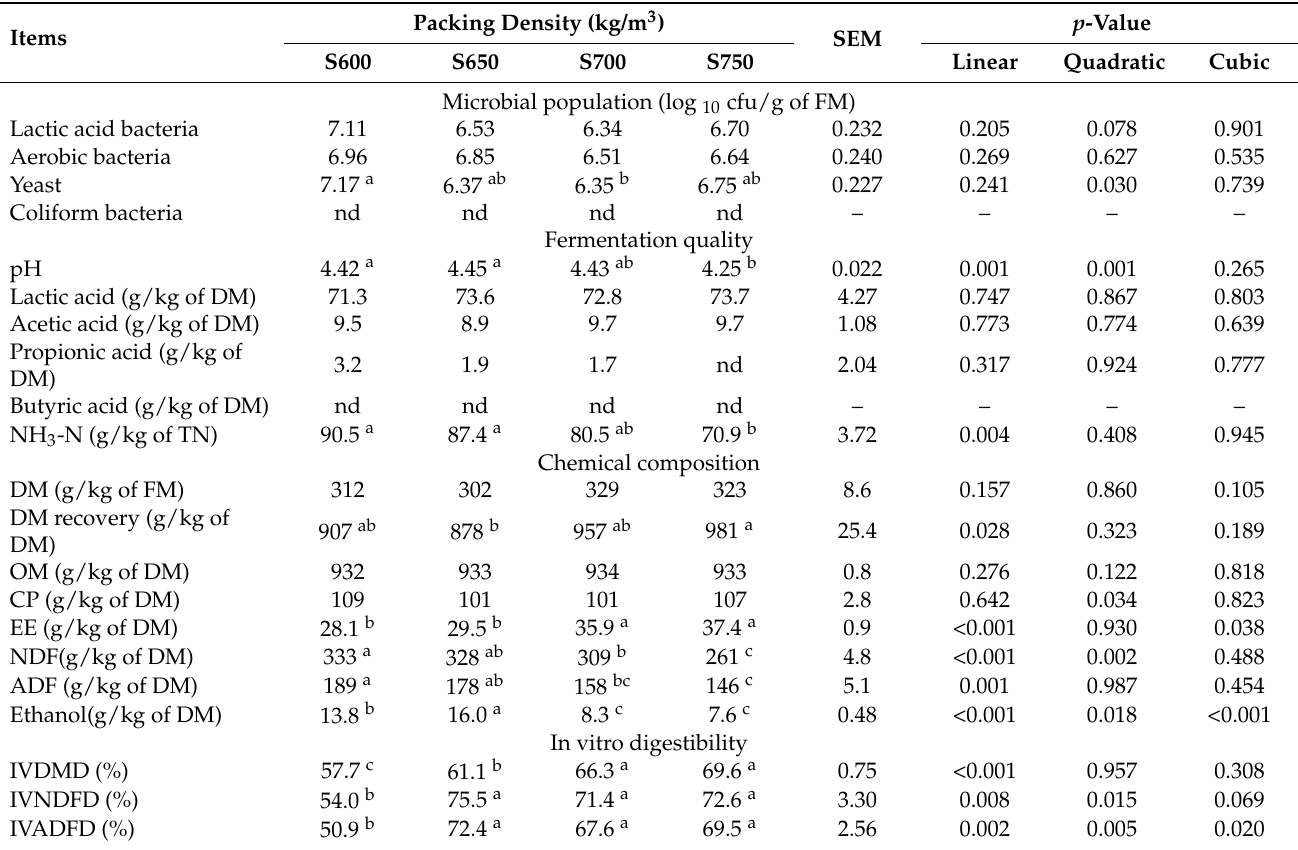
Table 3. Microbial population, fermentation quality, chemical composition, IVDMD, IVNDFD and IVADFD of barley silage after 60 days of ensiling ( n =